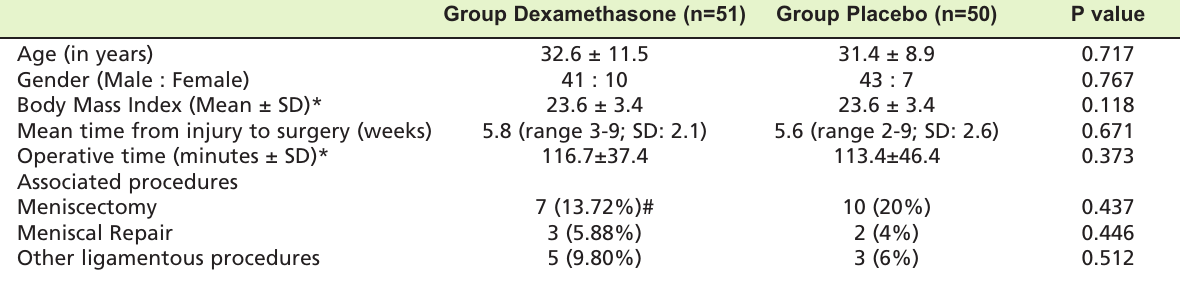
Patient characteristics and operative parameters Table I: